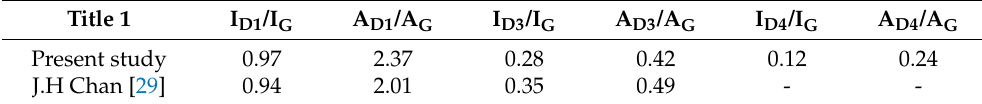
Figure 11. First-order Raman spectra for GDI PM. Table 4. I D1 /I G , A D1 /A G , I D3 /I G , A D3 /A G ,I D4 /IG, and A D4 /A obtained from Raman spectra.